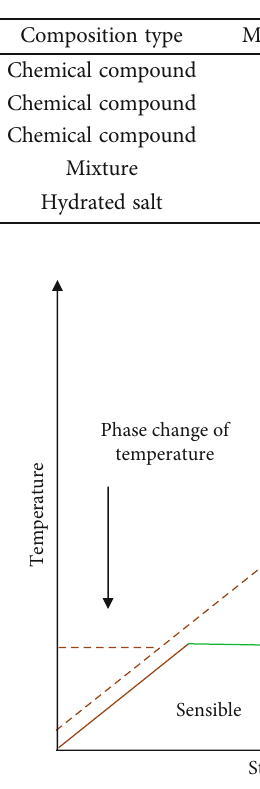
Figure 1: Classi fi cation of phase change Table 1: Thermal properties of di ff erent kinds of organic and inorganic material.